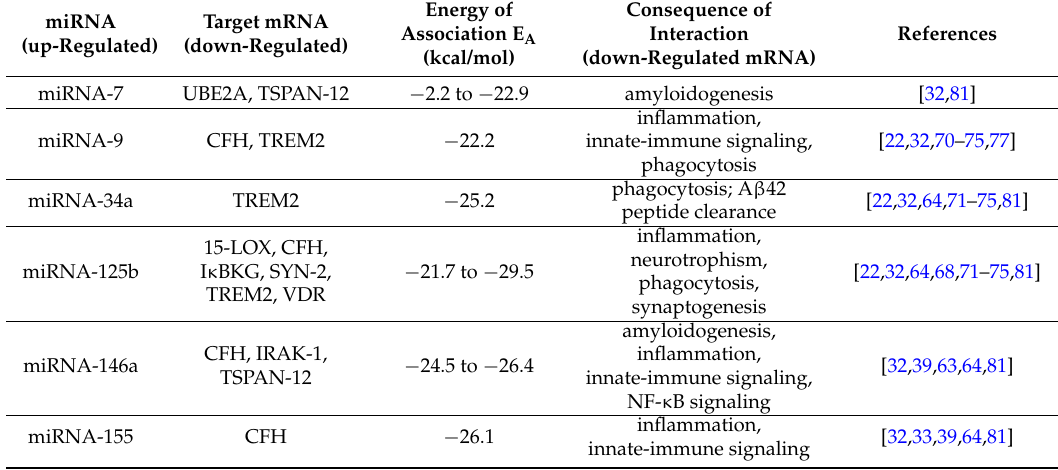
Table 1. Consequences of Up-regulated microRNAs (miRNAs) and Down-regulated messenger RNAs (mRNAs). miRNA Target mRNA (up-Regulated)